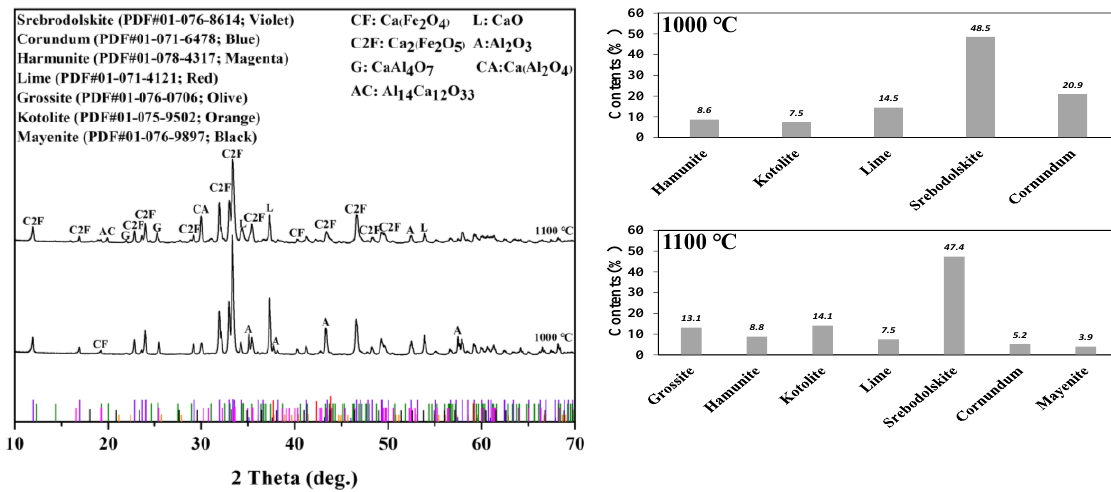
Figure 2. XRD patterns of CAF sintered at 1000 °C and 1100 °C.